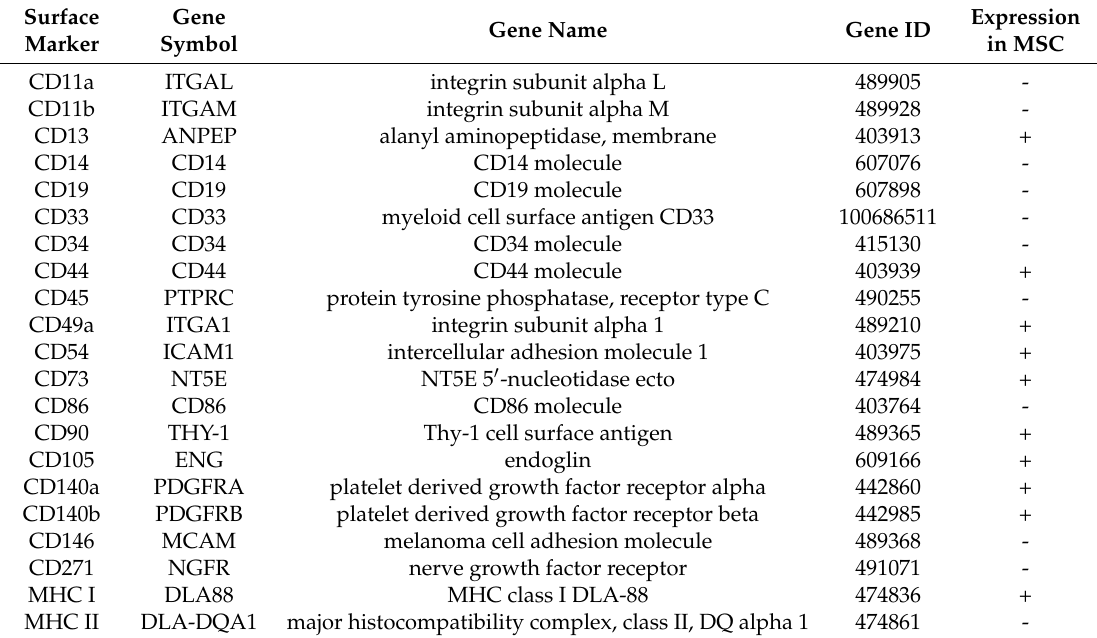
Table 1. Test results of the expression of canine MSC surface marker